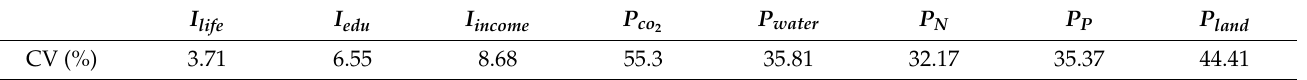
Table 5. The coefficient of variation of each boundary in